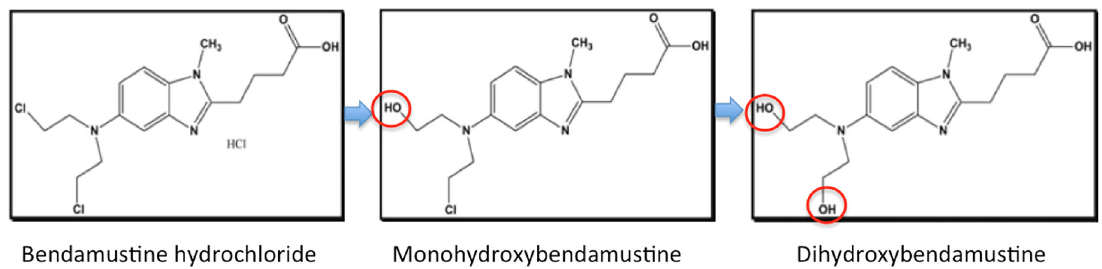
Figure 2: Chemical degradation of the nitrogen mustard structure